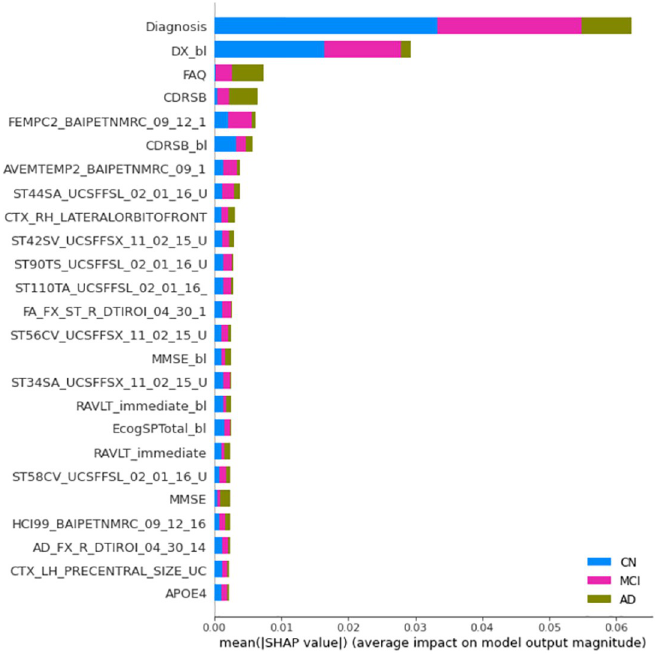
Fig 6. Mean absolute SHAP values computed from the SVM systems. Same legend than Fig